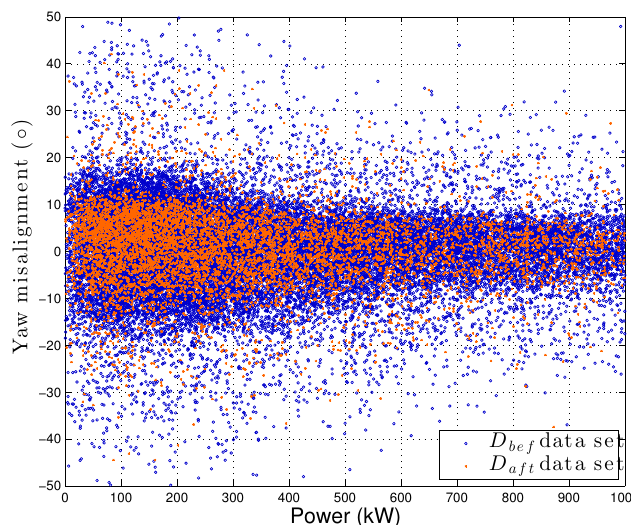
Figure 4. WTG02 yaw angle misalignment as a function of the power, for datasets D bef and D aft .